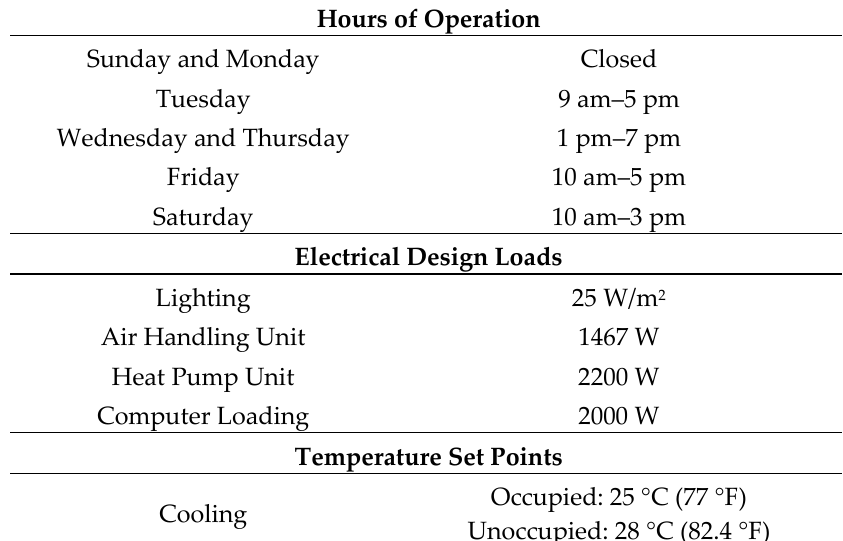
Table 1. Library building and GAHP parameters